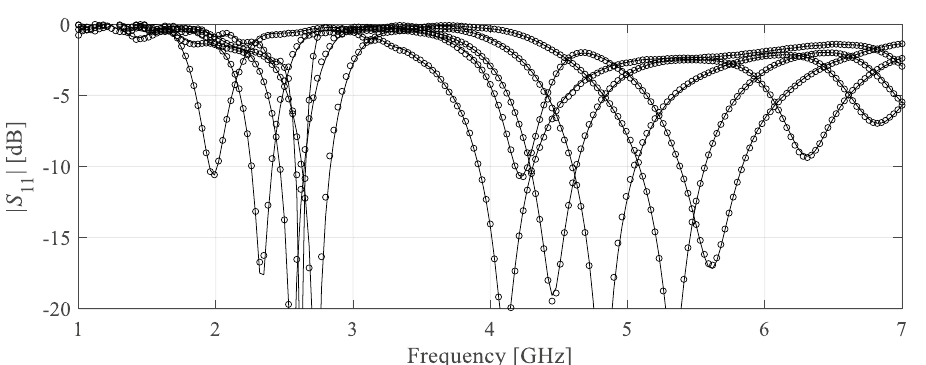
Figure 13. Antenna II: reflection responses at the representative test designs: full-wave model (—), and the presented two-level variable-fidelity surrogate (o) with N Bf = 50 and N Bc = 800.